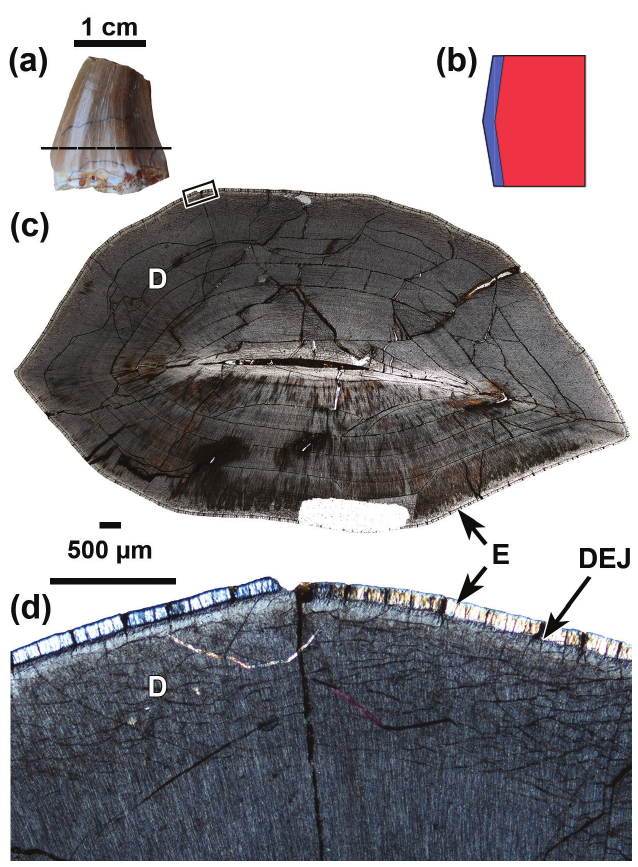
Figure 3. Anatomy of a fluted Gavialimimus almaghribensis tooth (MHNM.KHG.1231). A, tooth in labial view with ap - proximate plane of section indicated by the dashed line; B, schematic diagram illustrating the relationship between the enamel (blue) and the dentine (red); C, transverse section seen under plane polarized light. Box indicates the region magnified in (D). D, close-up of the dentine-enamel junction viewed under crossed polarized light. Abbreviations: D, dentine; DEJ, dentine-enamel junction; E,